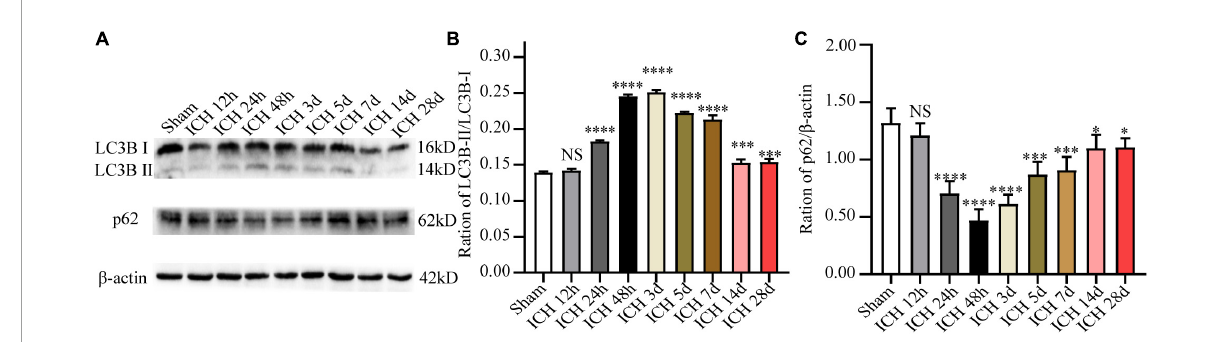
FIGURE2 The expression changes of autophagy-related proteins (LC3B and p62) at different time points after ICH. (A) Representative western blot images of LC3B and p62. (B,C) Quantitative analysis of LC3B and p62 in each group. ∗ p < 0.05, ∗∗∗ p < 0.001 and ∗∗∗∗ p < 0.0001 vs. the sham group; NS, non-significant different compared to the sham